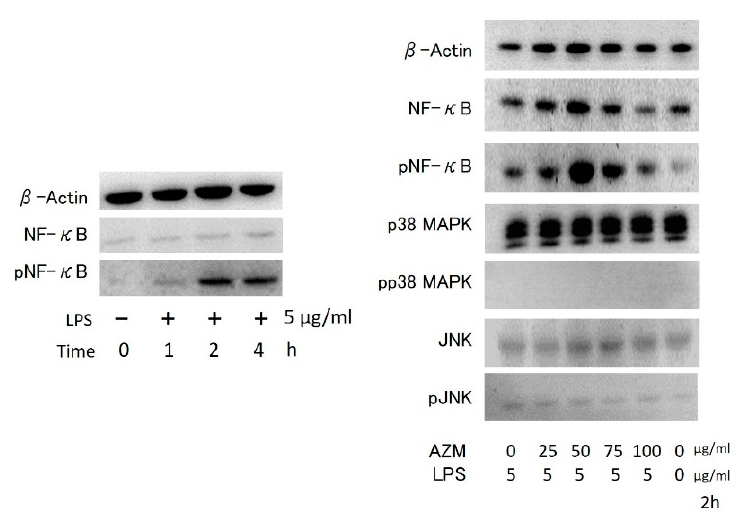
Figure 9. Effects on intracellular signaling molecules in hGFs in the presence of LPS and AZM.